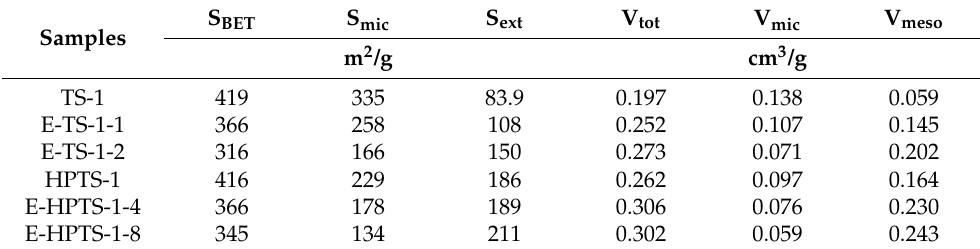
Table 1. Textural properties of extruded TS-1 and HPTS-1 samples.